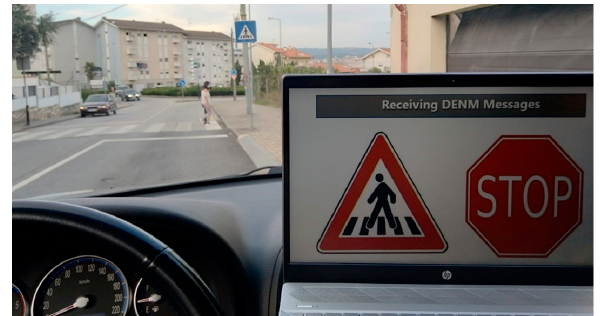
Figure 11. OBU station receiving DENM messages and presentation.